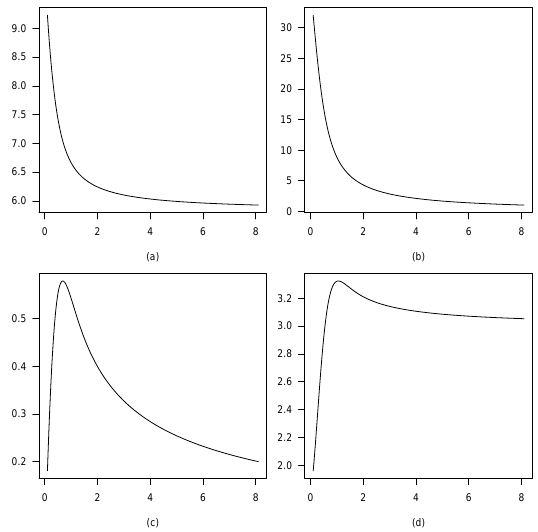
( θ , α ) } , for θ = 7.75, and α > 0. i